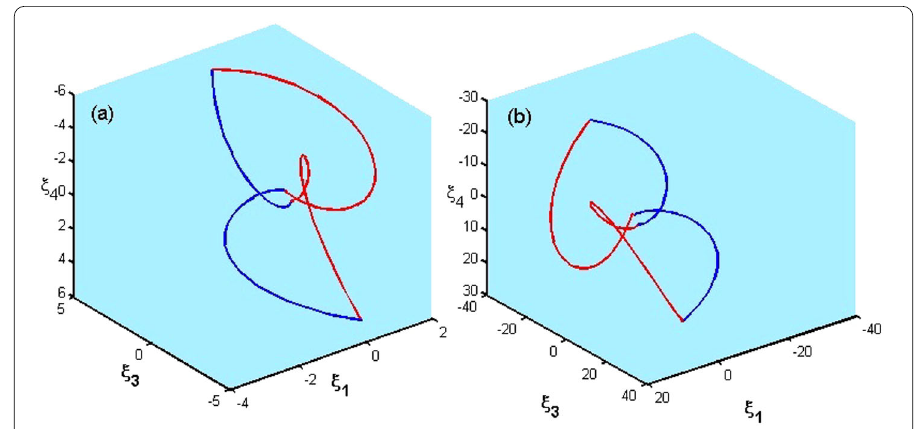
Figure 8 Period-two orbit established by: ( a ) ¯ ξ ∈ M 0 – the invariant surface of boundary of sliding mode, ( b ) ¯ ξ ∈ M c – which is any point in the crossing